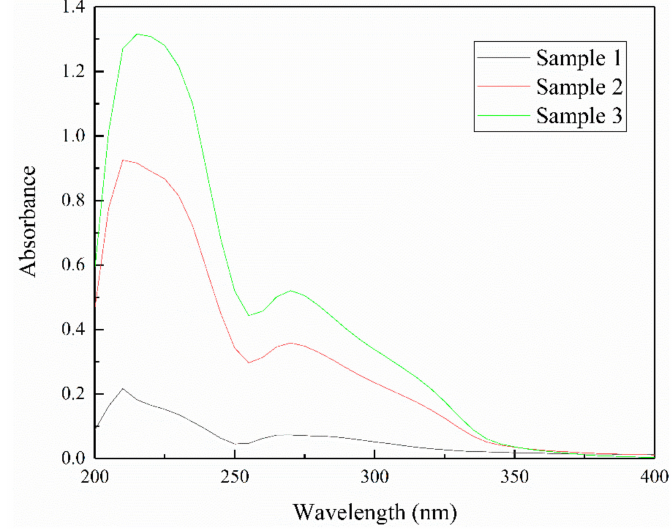
Figure 5. UV absorbance spectra of the three samples after reaction with xanthate.